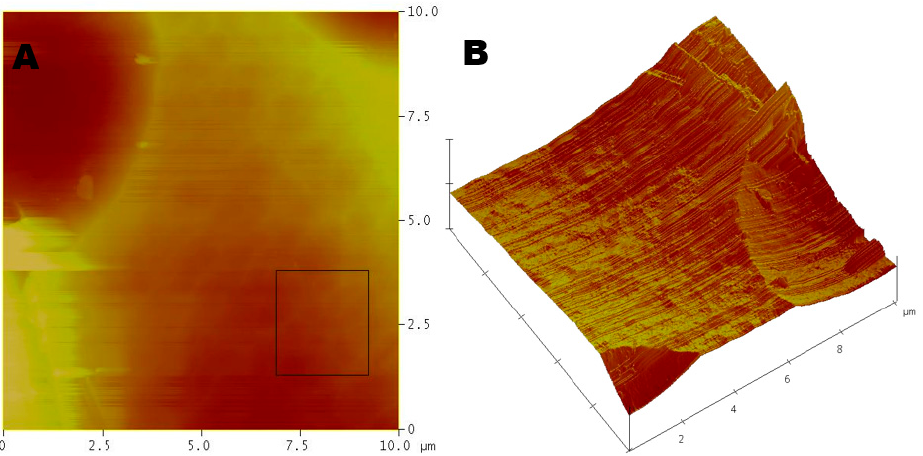
Figure 4. Atomic force microscopy of aluminum post-electropolishing with phosphoric acid in ( A ) 2D and ( B ) 3D—recording an average roughness of 97 ± 6 nm by utilizing the root mean square method for calculation. A 10 × 10 µm recording region was utilized.